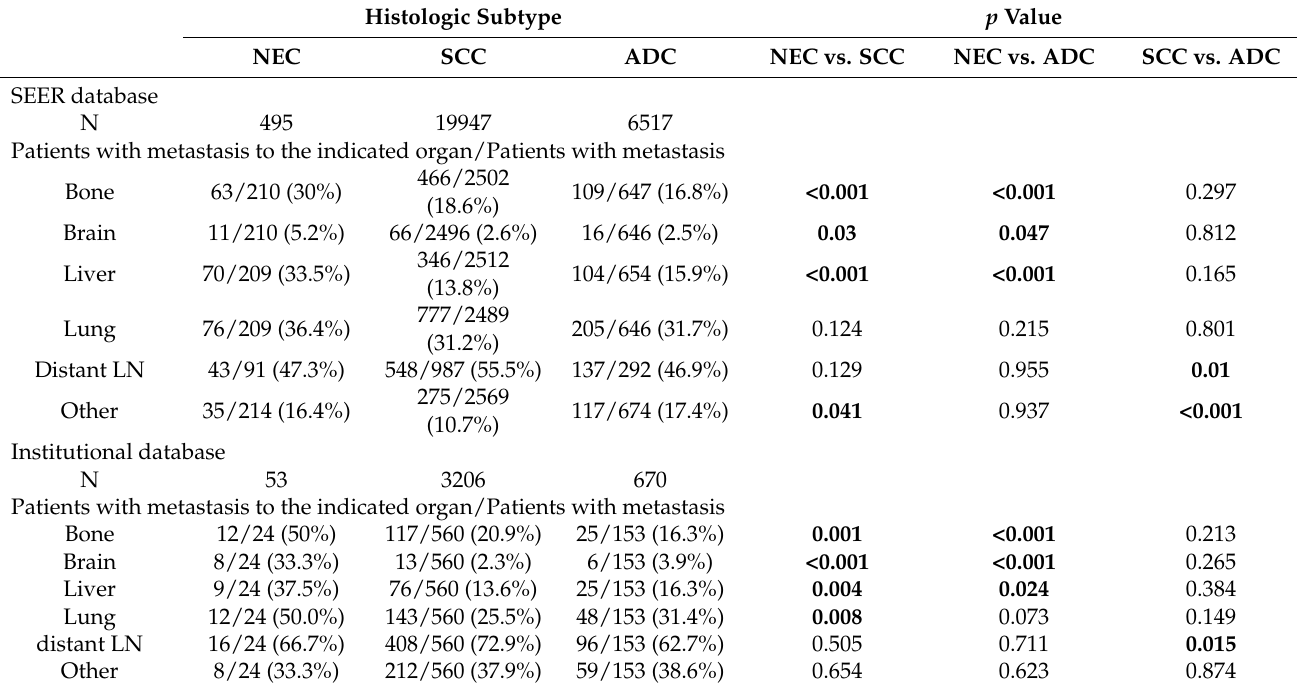
Table 1. Comparison of the rates of organotrophic metastasis among different histologic subtypes of uterine cervical carcinomas retrieved from the Surveillance, Epidemiology, and End Results (SEER) database and an institutional database. Each percentage indicates the percentage of patients with metastasis to the indicated organ divided by the total number of patients with